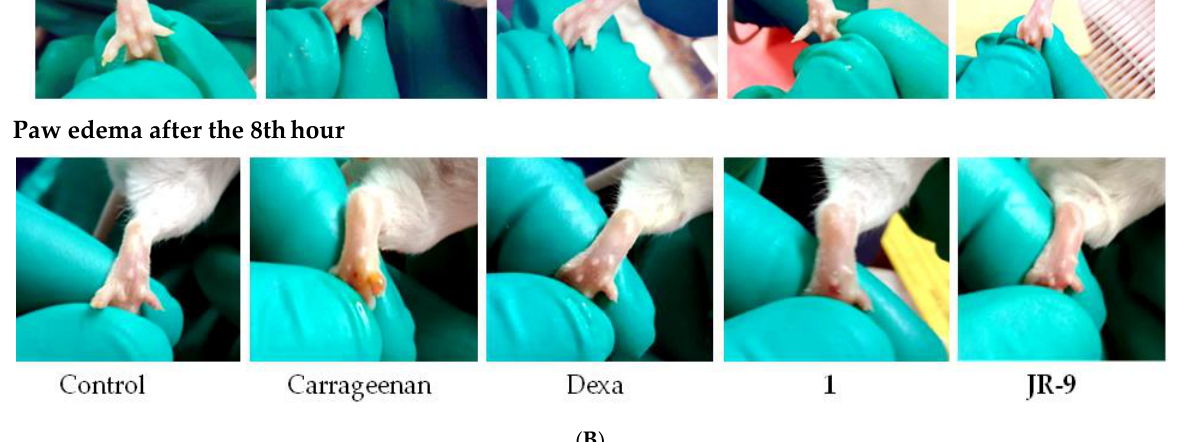
Table 4. Effect of 1 and JR-9 on biochemical and hematological parameters in Female BALB/c mice. Values are expressed as mean ± SD for five female mice in each group. RBC: red blood count; HCT: hematocrit; MCV: mean corpuscular volume; WBC: white blood cells; ALT: alanine aminotrans- ferase; AST: aspartate aminotransferase; ALP: alkaline phosphatase. S. No.